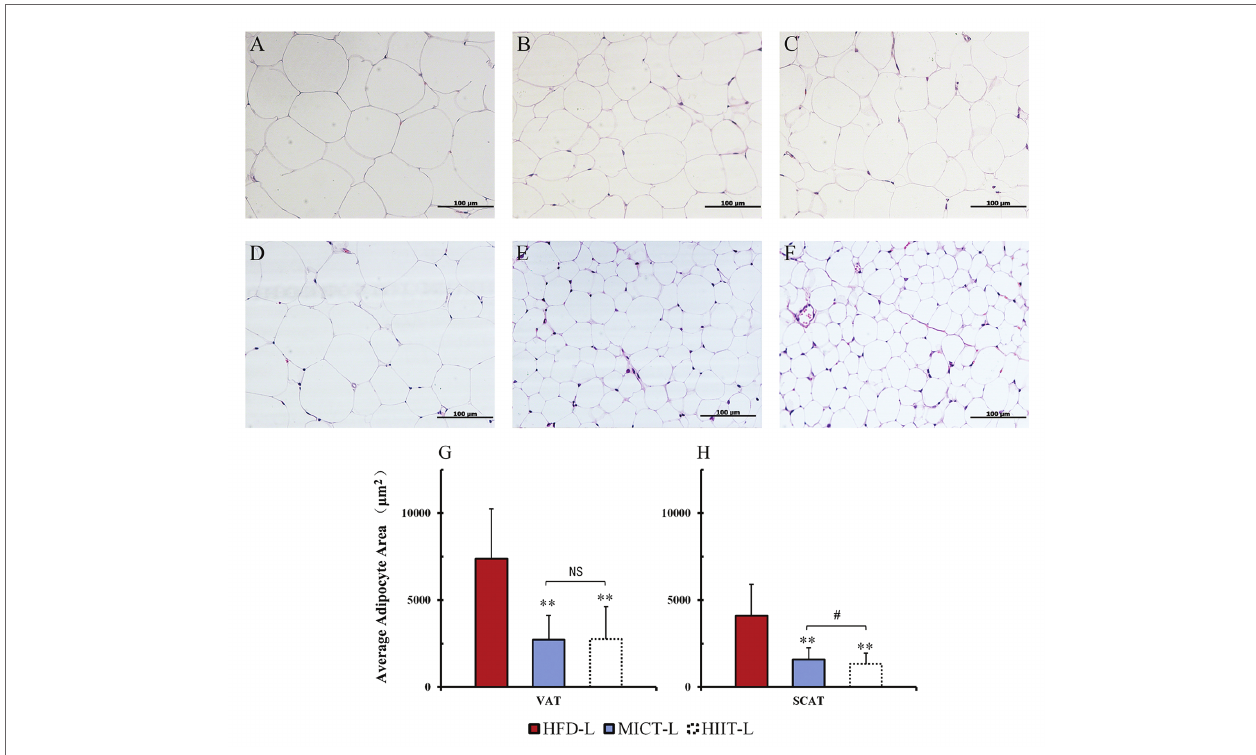
FIGURE 4 | Adipocyte sizes of different fat depots. Periuterine adipocytes (VAT) of HFD-L (A) , MICT-L (B) , and HIIT-L (C) , as well as inguinal adipocytes (SCAT) of HFD-L (D) , MICT-L (E) , and HIIT-L (F) were shown by H&E staining; Average adipocyte area (G,H) ; ** p < 0.01 vs. HFD-L, # p < 0.05 MICT-L vs. HIIT-L, and NS, no significant difference. Images shown are representative for overall results.